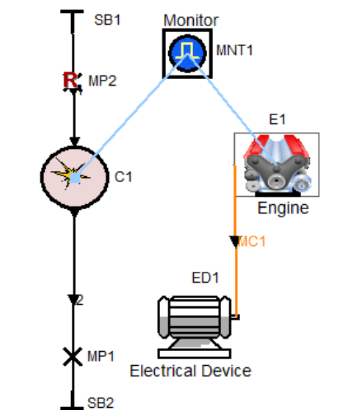
Fig. 4. One dimensional model of the engine in the AVL BOOST